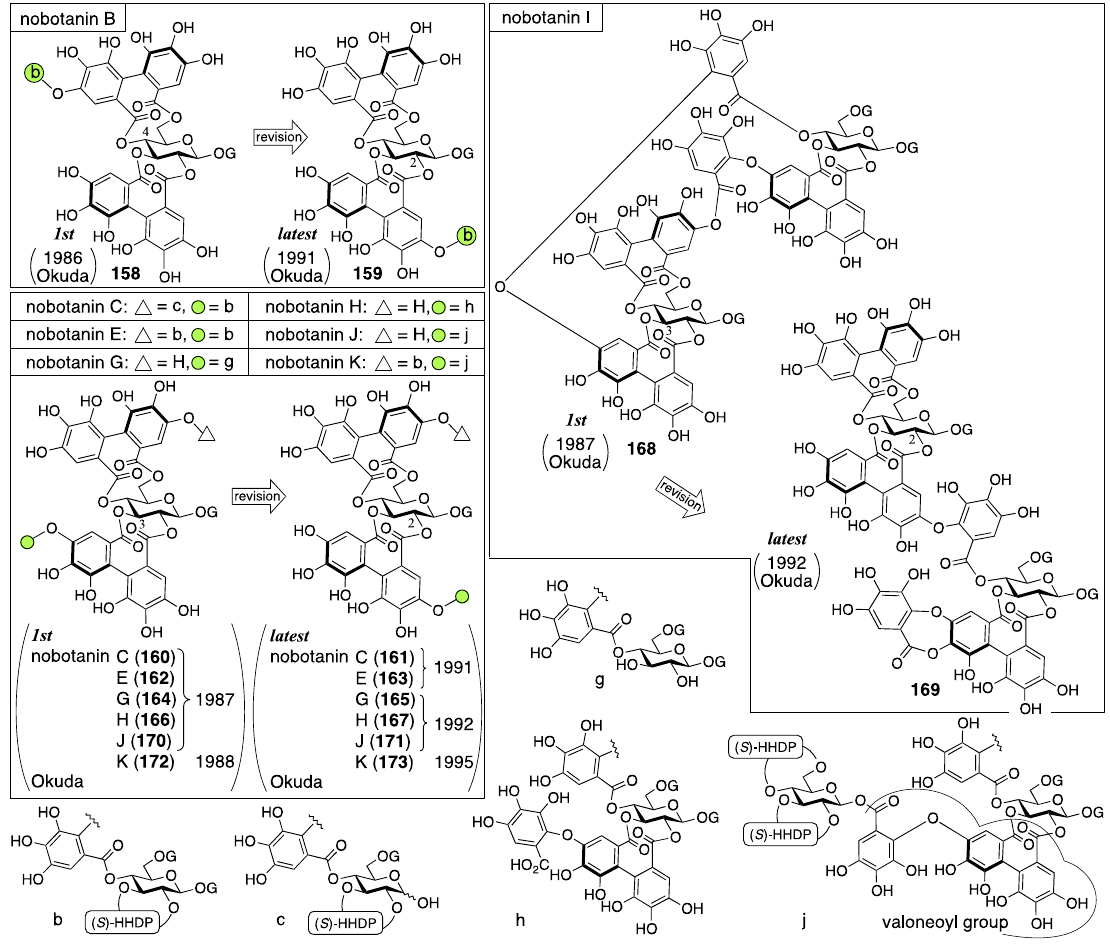
Figure 53. The transition of the structure of nobotanins B, C, E, G, H, I, J, and K. The green is merely a mark. The usage is the same in the following figures.